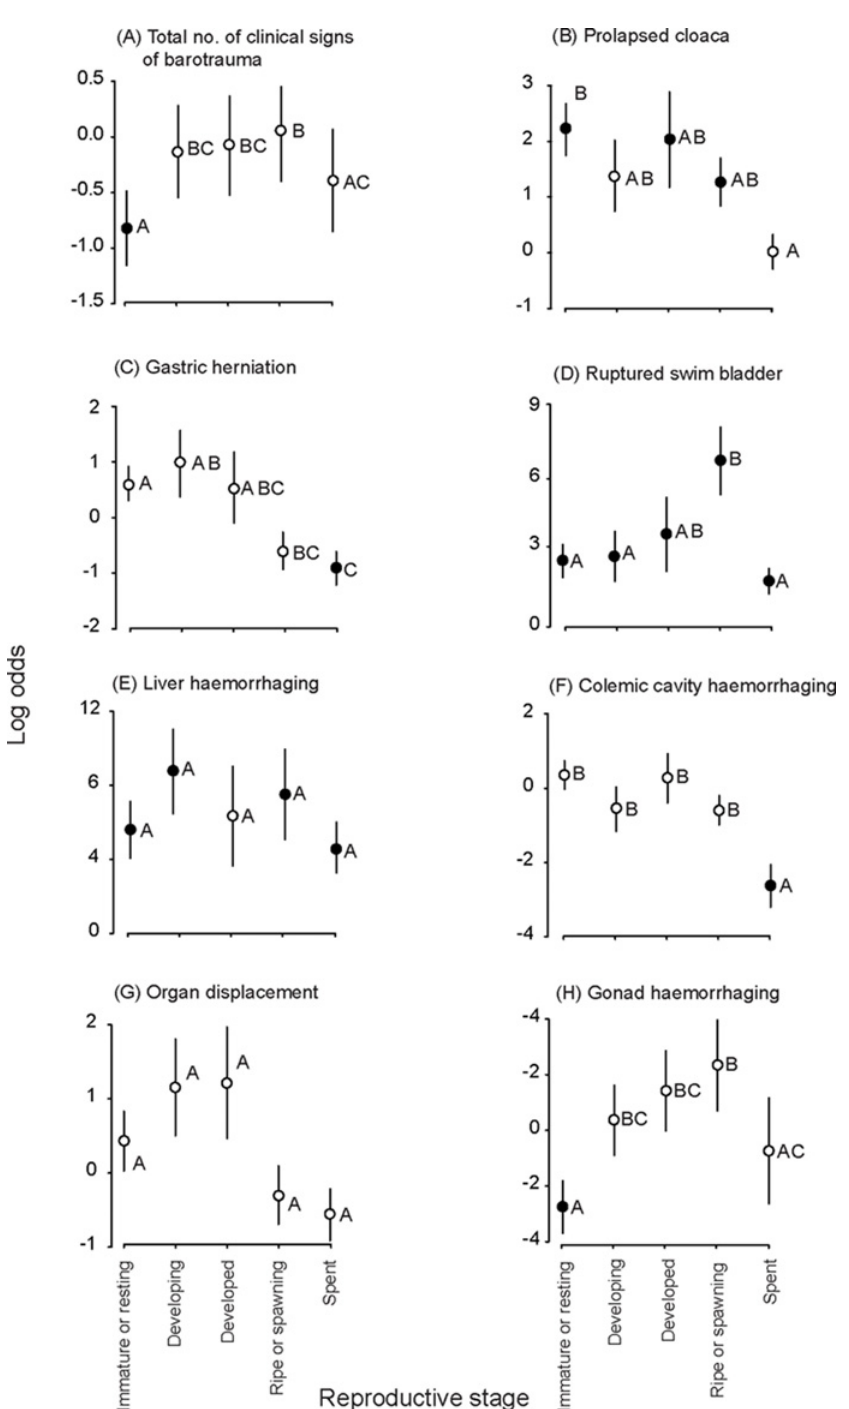
Fig 2. Log odds ( ± SE; standardized to mean depth) from logistic models across five reproductive stages of Chrysophrys auratus for (A) the total number of clinical signs of barotrauma, (B) prolapsed cloaca, (C) gastric herniation, (D) ruptured swim bladder, (E) liver haemorrhaging, (F) coelomic cavity haemorrhaging, (G) organ torsion and (H) gonad haemorrhaging. The significance of the log odds is designated by either black ( p < 0.05) or white ( p > 0.05) circles, while the dissimilar letters represent differences detected in false-discovery-rate pairwise comparisons ( p < 0.05).